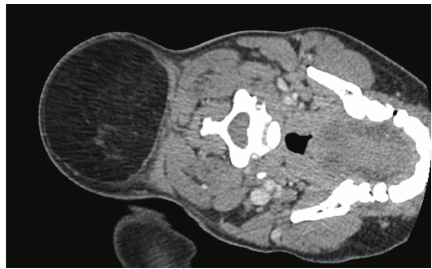
Figure 1: CT image showing a slice of a large posterior cervical li- poma which spanned from the patient’s occiput through the length of the patient’s cervical